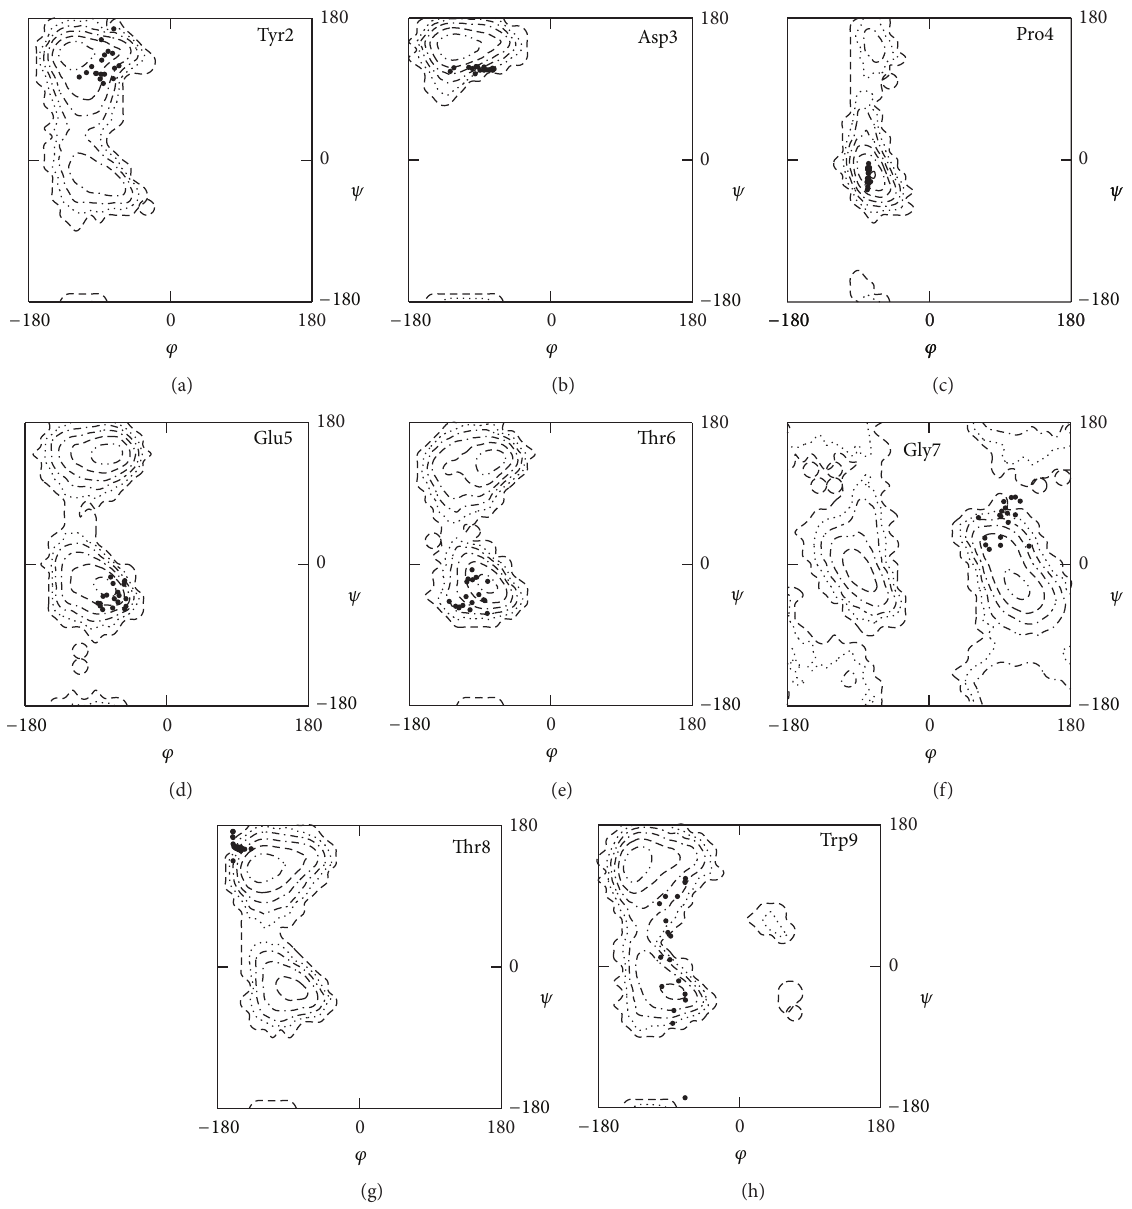
Figure 8: Ramachandran-type free-energy surfaces for Tyr2–Trp9 residues of chignolin obtained from all trajectories of the SAAP-MC simulation at 300 K in water along with the plots of the native structures determined by NMR [58]. Contour lines are drawn in an interval of